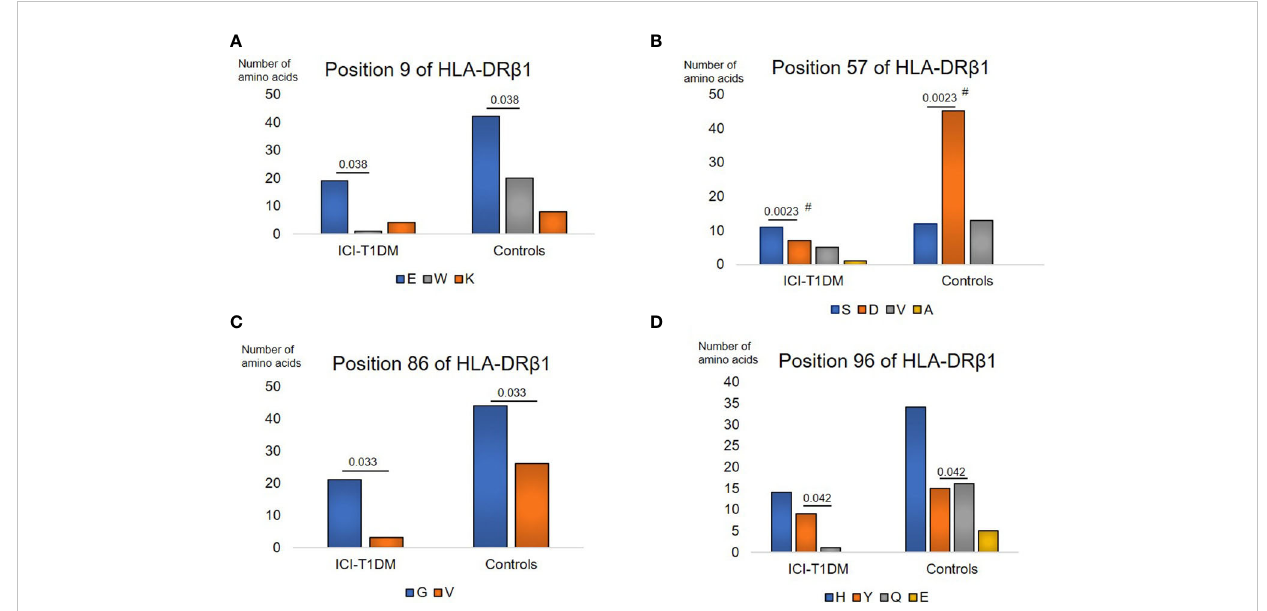
FIGURE 1 Prevalence of amino acid carriages at residues of HLA-DRB1 allele in patients with ICI-T1DM and ICI-controls (shown as controls) (A – D) . Prevalence of amino acid at position 9, E, Glutamic acid vs W, Tryptophan, P=0.038. OR 9.05, 95% CI: 1.13-72.43 (A) , position 57, S, Serine vs D, Aspartic acid, P=0.0023. OR 5.89, 95%CI: 1.88-18.46 (B) , position 86, G, Glycine vs V, Valine, P=0.033. OR 4.14, 95%CI: 1.12-15.23 (C) , and position 96, Y, Tyrosine vs Q, Glutamine, P=0.042. Odds ratio of 9.60, 95%CI: 1.08-85.16 (D) are shown. After Bonferroni correction for all signi fi cant amino acid polymorphisms among HLA-DRB1 alleles, only amino acid position 57 on HLA-DRB1 allele (B) was signi fi cantly different (Pc=0.046 after Bonferroni correction, shown with #).